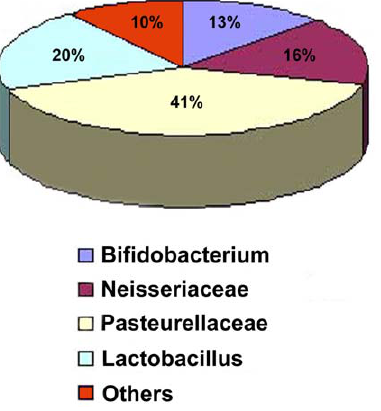
Figure 6. Pie chart showing the percentage of Bifidobacterium, Neisseriaceae, Pasteurellaceae and Lactobacillus and uncom- mon bacteria types identified in worker bees.